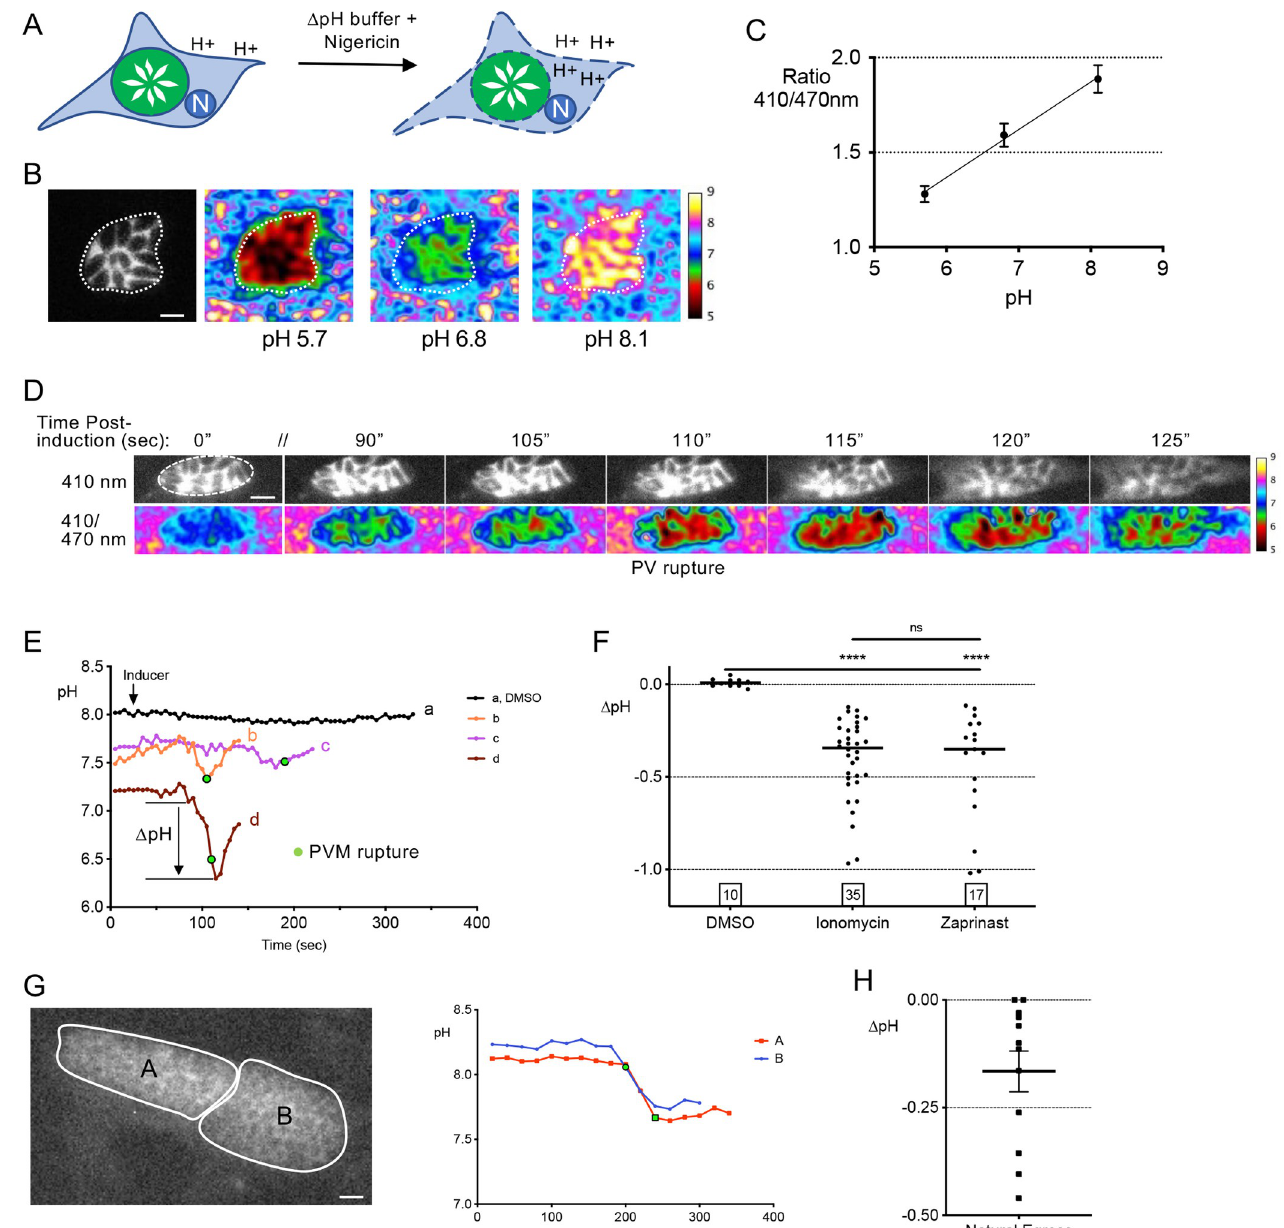
Fig 1. Measurement of pH in T . gondii PVs expressing ratiometric pHluorin. A) Equilibration of vacuoles to the surrounding buffer of known pH values with nigericin. B) Vacuole ratio images at 410/470 nm that are false colored according to the scale shown to the right. C) Calibration curve from the ratio 410/ 470 nm values for each pH value (mean ± S.D); R 2 = 0.9992. Scale bar, 5 μ m. D) Reductions in PV pH during egress observed by live imaging of ionomycin- induced RH-RatpH parasites. The upper image series is from excitation at 410 nm to visualize the time of egress i.e., when pHluorin first leaves the PV due to rupture of the PVM. The lower series is of ratio images according to the pH scale bar shown on the right. // indicates a gap in time. E) The magnitude of pH changes varies between PVs. Tracings of pH values of RH-RatpH PVs induced with DMSO (a) or ionomycin (b, c, d). Tracing d represents the vacuole shown in 1D. Image acquisition was paused following frame 5 (25 sec), inducer was added, and acquisition was started again. Green data points indicate the time when pHuorin first leaves the PV, which is designated as the time of egress. F) A significant reduction in PV pH occurs after ionomycin or zaprinast induction of egress. Data points represent changes in PV pH starting from baseline to a drop greater than 0.05 following induction with either ionomycin or zaprinast. Numbers in squares within the graph indicates the numbers of PVs enumerated. A Kruskal-Wallis test with Dunn’s multiple comparison was performed. ���� p � 0.0001. Bars indicate the median. ns, not significant. G) A drop in PV pH occurs during natural egress. Representative PVs late in replication (~50 h) and pH tracings associated with egress. Scale bar, 10 μ m. H) Quantification of pH changes in PVs during natural egress. Bar indicates the mean.